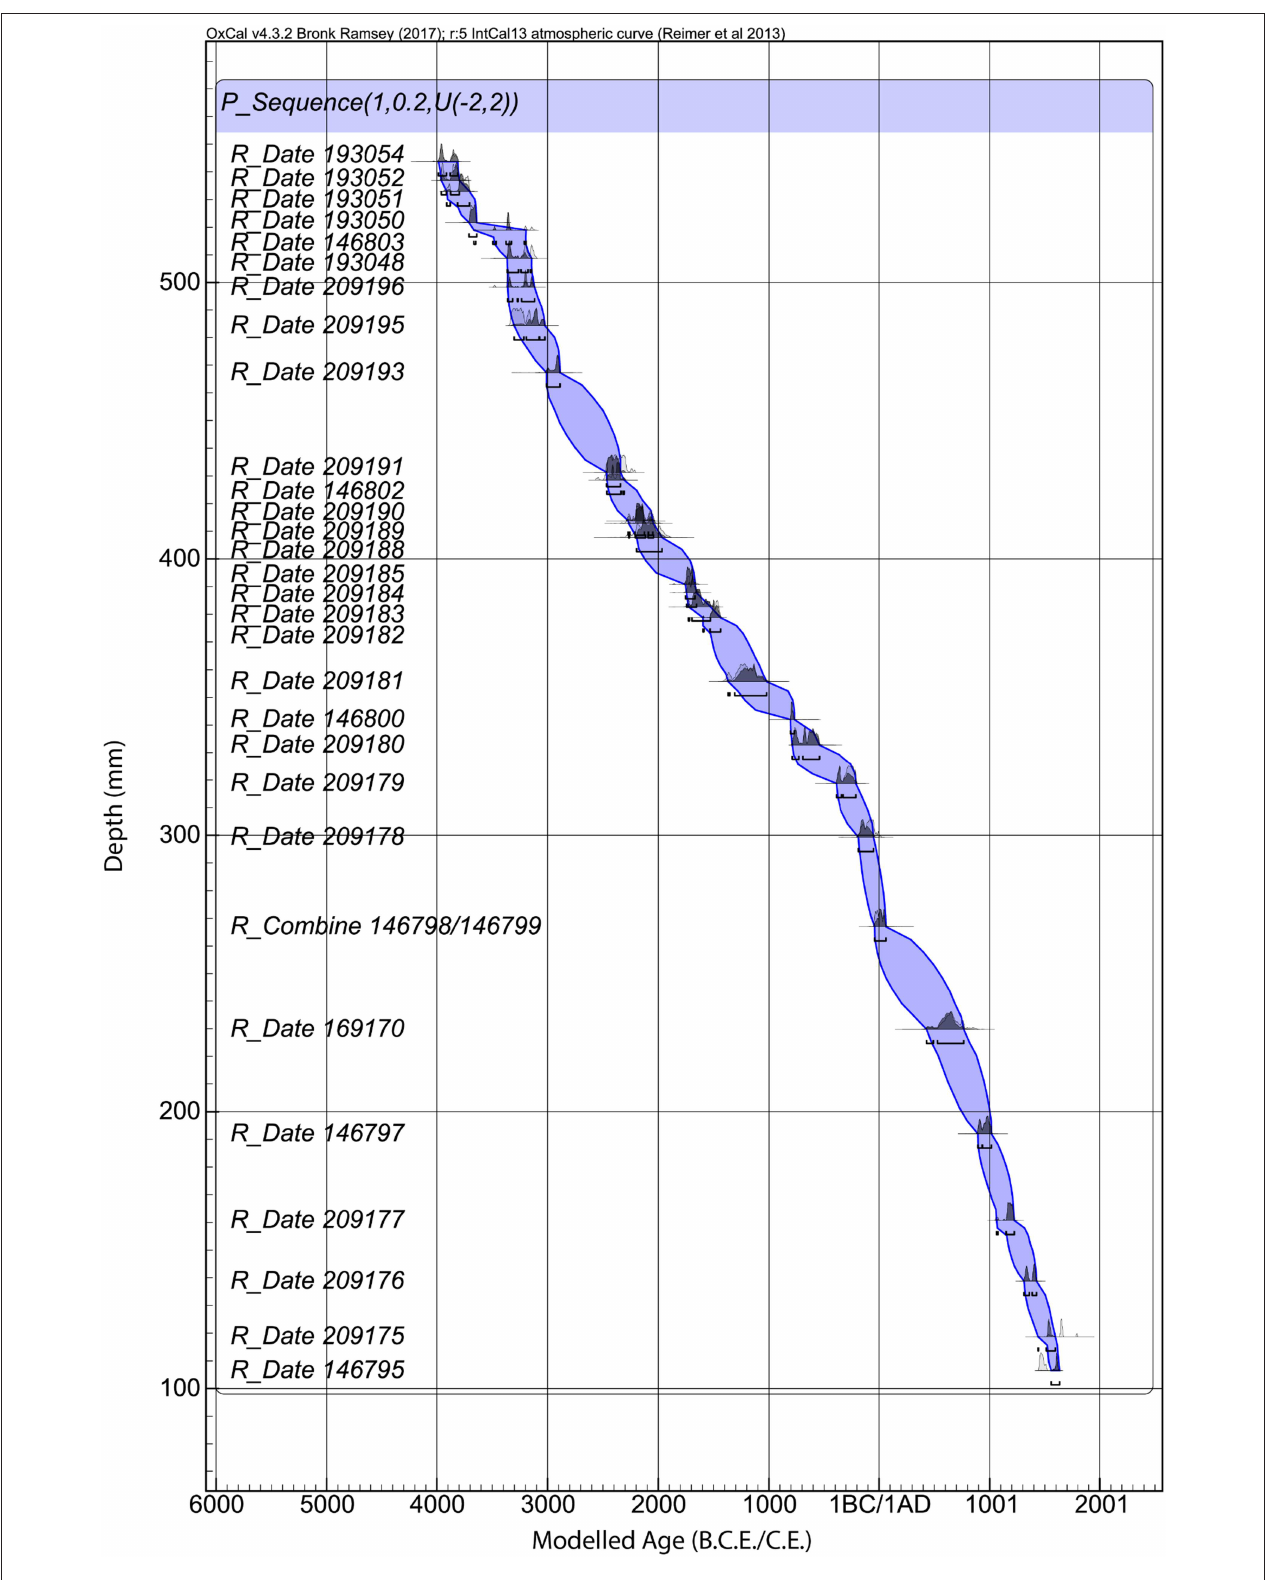
FIGURE 3 | Age depth model for Cenote Kail.